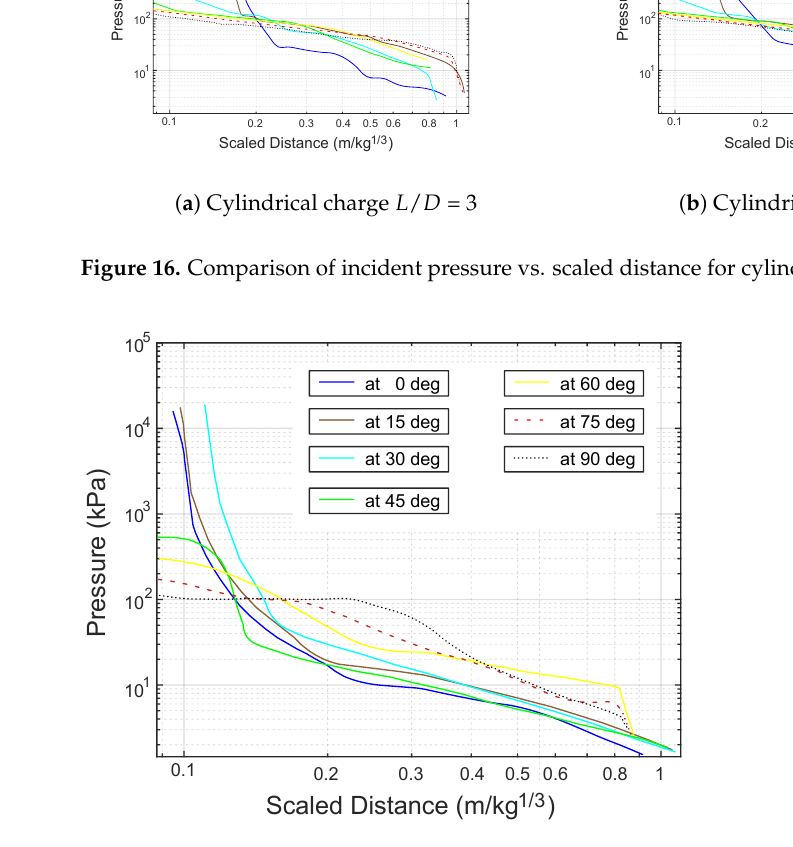
Figure 17. Comparison of incident pressure vs. scaled distance for 3D conic charge L / D =